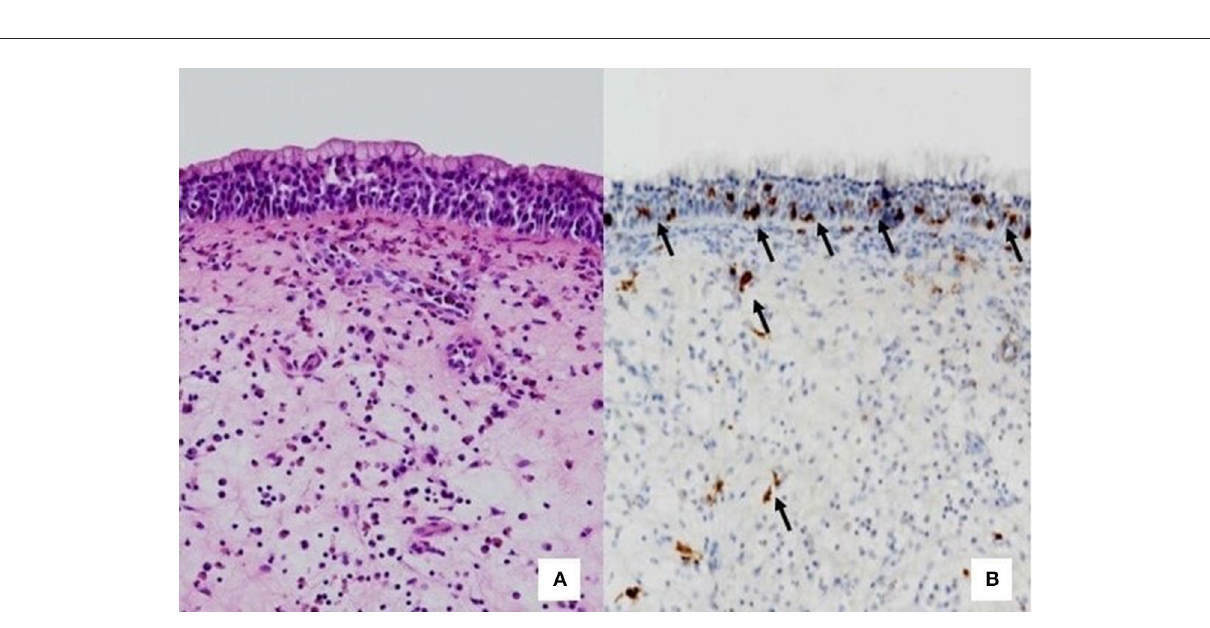
FIGURE2 Comparison between histology and immunohistochemistry. (A) HE staining that do not highlight mast cells. (B) Immunohistochemistry. The arrows indicate CD117 + mast cells, located at the intraepithelial level or in the lamina